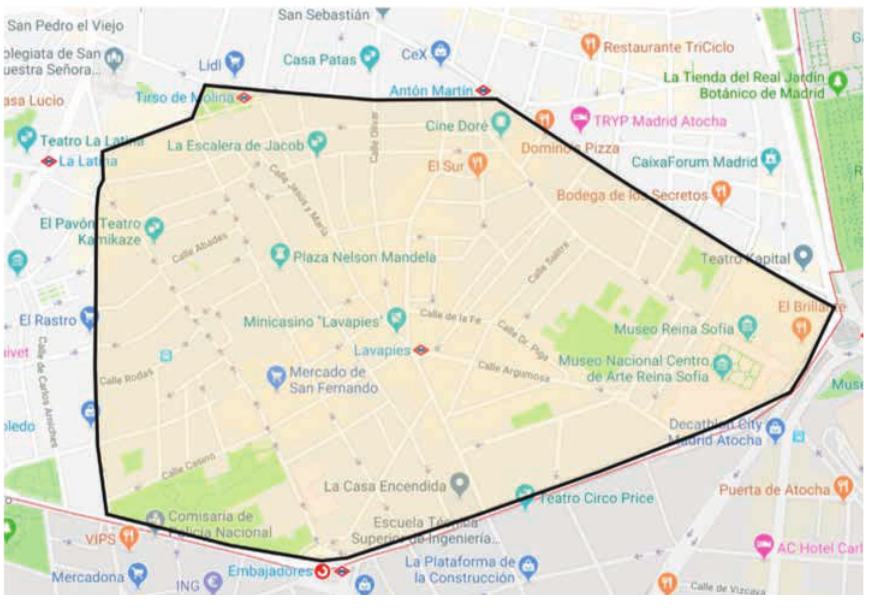
Figure 1. Map of Lavapiés. Source: Google